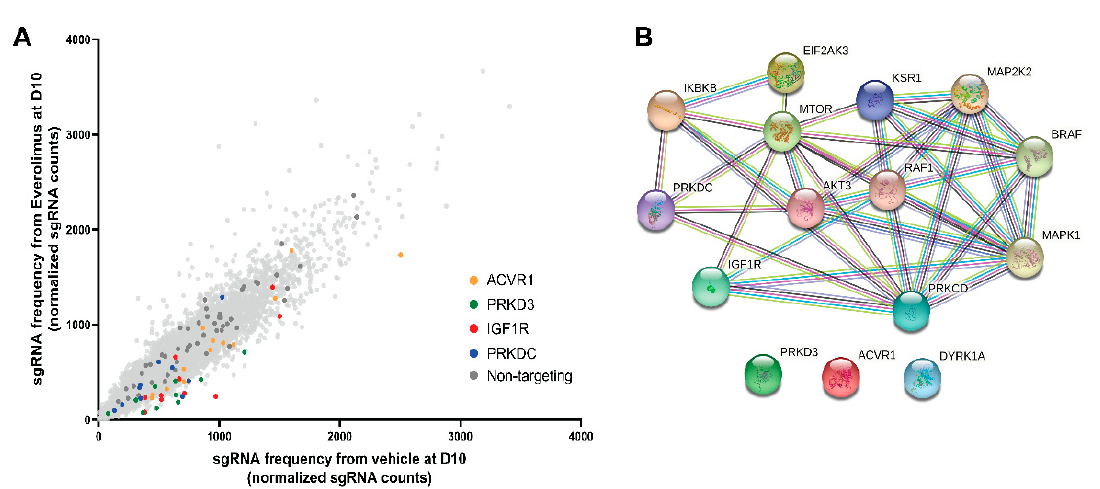
Figure 2. A CRISPR/Cas9 screen indicates IGF1R and PRKDC as putative synthetic lethal pairs with mTOR inhibition. ( A ) Enrichment of the selected sgRNAs on day 10 versus day 0. The cells were transduced with lentiviral particles expressing both Cas9 and sgRNAs targeting the human kinome and were subsequently treated with 10 nM everolimus or vehicle for 10 days. The frequency of sgRNA representation in everolimus vs. vehicle subsets on day 10 is plotted. Each dot corresponds to a particular sgRNA: yellow dots represent sgRNAs targeting ACVR1 , green dots represent sgRNAs targeting PRKD3 , red dots represent sgRNAs targeting IGF1R , blue dots represent sgRNAs targeting PRKDC , dark gray dots represent non-targeting sgRNAs. ( B ) STRING network of CRISPR/Cas9 screen top hits. Each sphere refers to a protein corresponding to a hit gene. Edges represent associations between the proteins based on known interactions from curated databases (blue), experimentally determined interactions (magenta), or interactions predicted by gene neighborhood (green), gene fusions (red), or gene co-occurrence (dark blue). Other types of interactions are identified by text mining (light green), co-expression (black), and homology (violet).